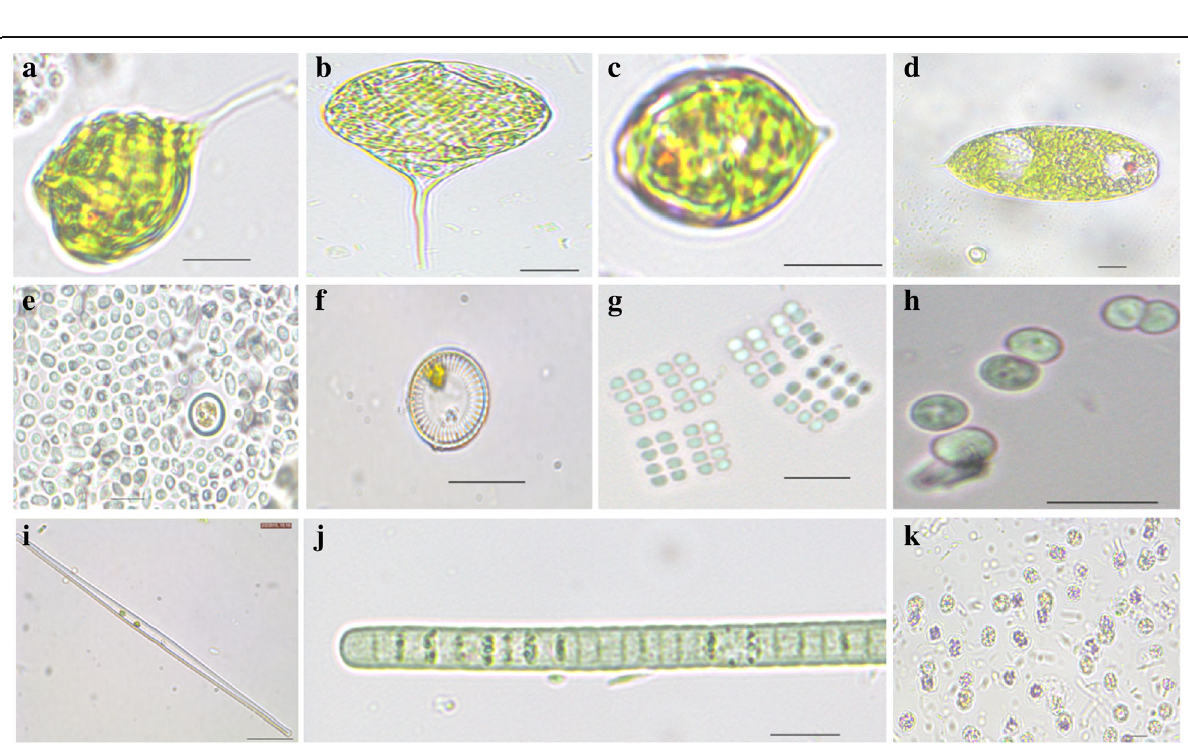
Fig. 4 Photomicrograph of phytoplankton observed during the present study a . Phacus pyrum, b . Phacus longicauda, c . Lepocinclis fusiformis, d . Euglena splendens, e . Synechococcus sp., f . Stephanocyclus meneghiniana g . Merismopedia minima, h . Synechocystis aquatilis, i . Nitzschia acicularis, j . Oscillatoria limosa, k . Microcystis aeruginosa.Scale bar,10 μ